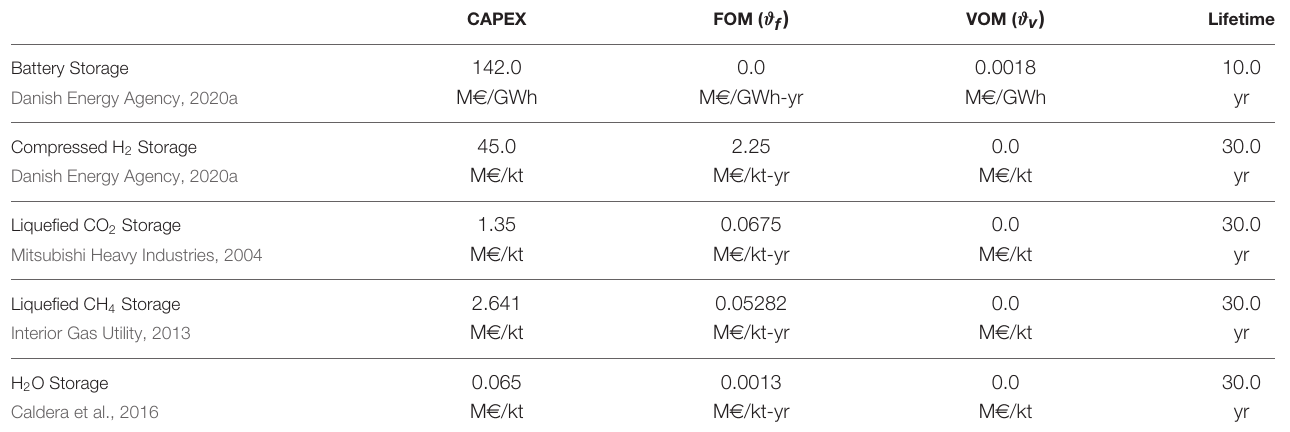
TABLE 4 | Economic parameters used to model storage nodes (stock component, 2030